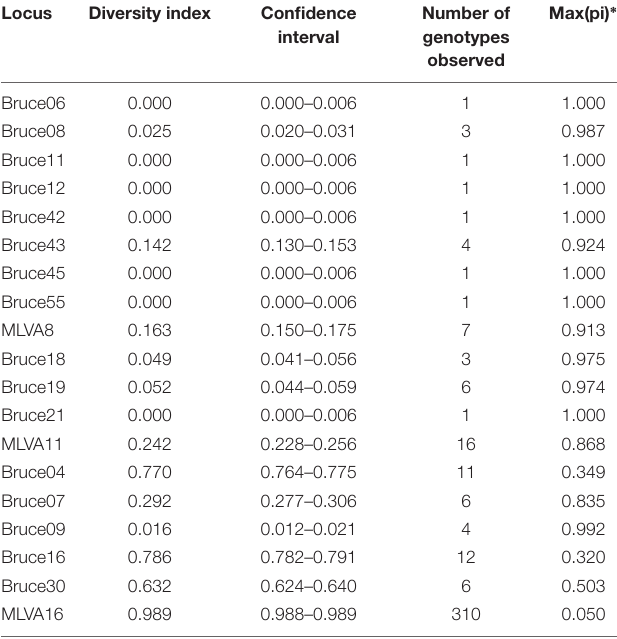
TABLE 1 | Hunter and Gaston diversity index (HGDI) for loci and MLVA panels for 1327 B. melitensis strains from human patients in Kazakhstan. Locus Diversity index Confidence Number of interval genotypes